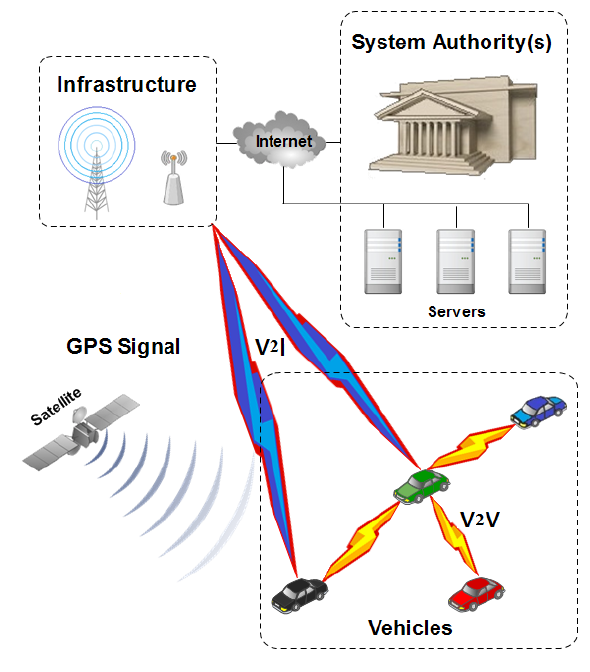
Figure 3. The different entities of the vehicular network.